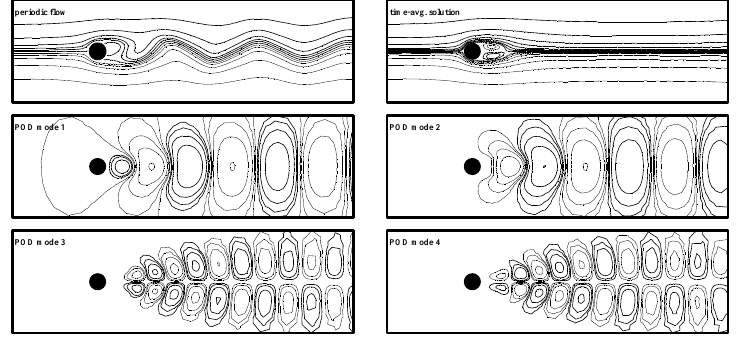
Figure 1. Streamlines of a snapshot (top-left), time-averaged solution (top-right) and first four POD modes for an incompressible flow around circular cylinder.